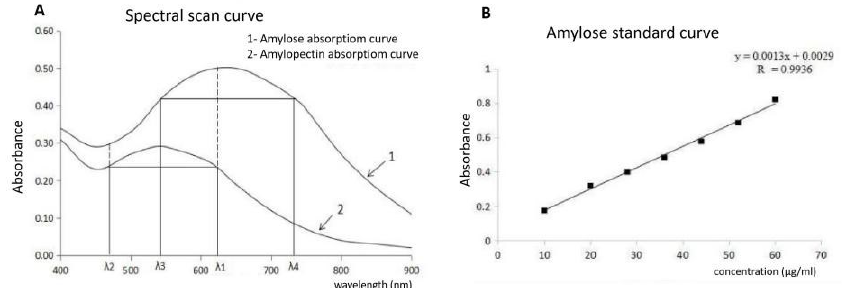
Figure 10. Drawing the standard curve of amylose. ( A ): Preparation analysis of amylose and amylopectin ( B ): Standard curve of amylose.